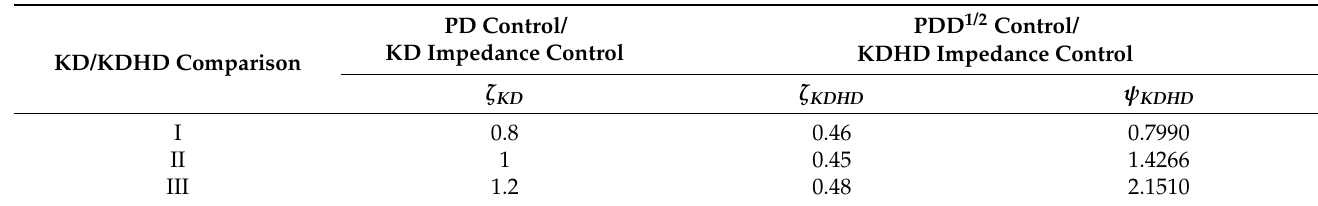
Table 2. Nondimensional parameters of the compared PD and PDD 1/2